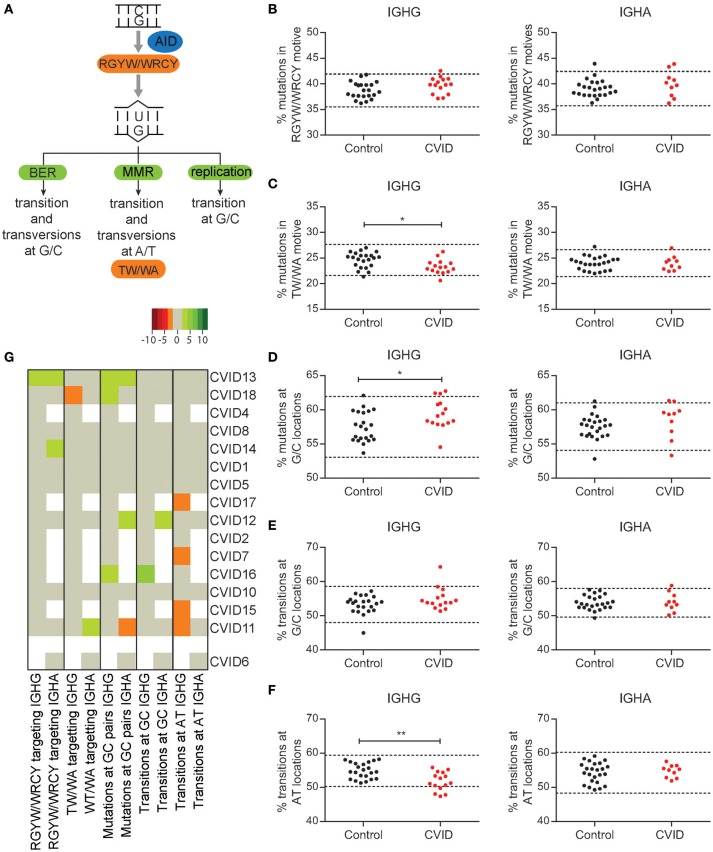
Minor skewing in SHM patterns are found in a subgroup of CVID patients. (A) A schematic overview of the different pathways by which AID induced U lesions can be repaired and the mutation patterns they are linked to. The percentages of mutations located in RGYW/WRCY (B) and TW/WA (C) motives in IGHA and IGHG rearrangements of HC's and CVID patients. (D) Percentage of mutations located at G/C locations. The percentage of mutations located at G/C (E) or A/T (F) locations that are transitions. The dotted lines represent the mean ±2 standard deviations (st dev) of the HC. (G) Heatmap showing the different aspects of SHM patterns per patient. Values < 2 st dev below the mean are depicted in increasingly darker shades of red, while values >2 st dev above the mean are depicted in increasingly darker shades of green. Patients (except CVID6) are clustered based on all data included in the heatmap. Dotted lines in graphs B-F represent the mean plus and minus 2 st dev of the HC. Statistical significance is performed using a Mann Whitney-test and indicated using *P < 0.05 and **P < 0.001.